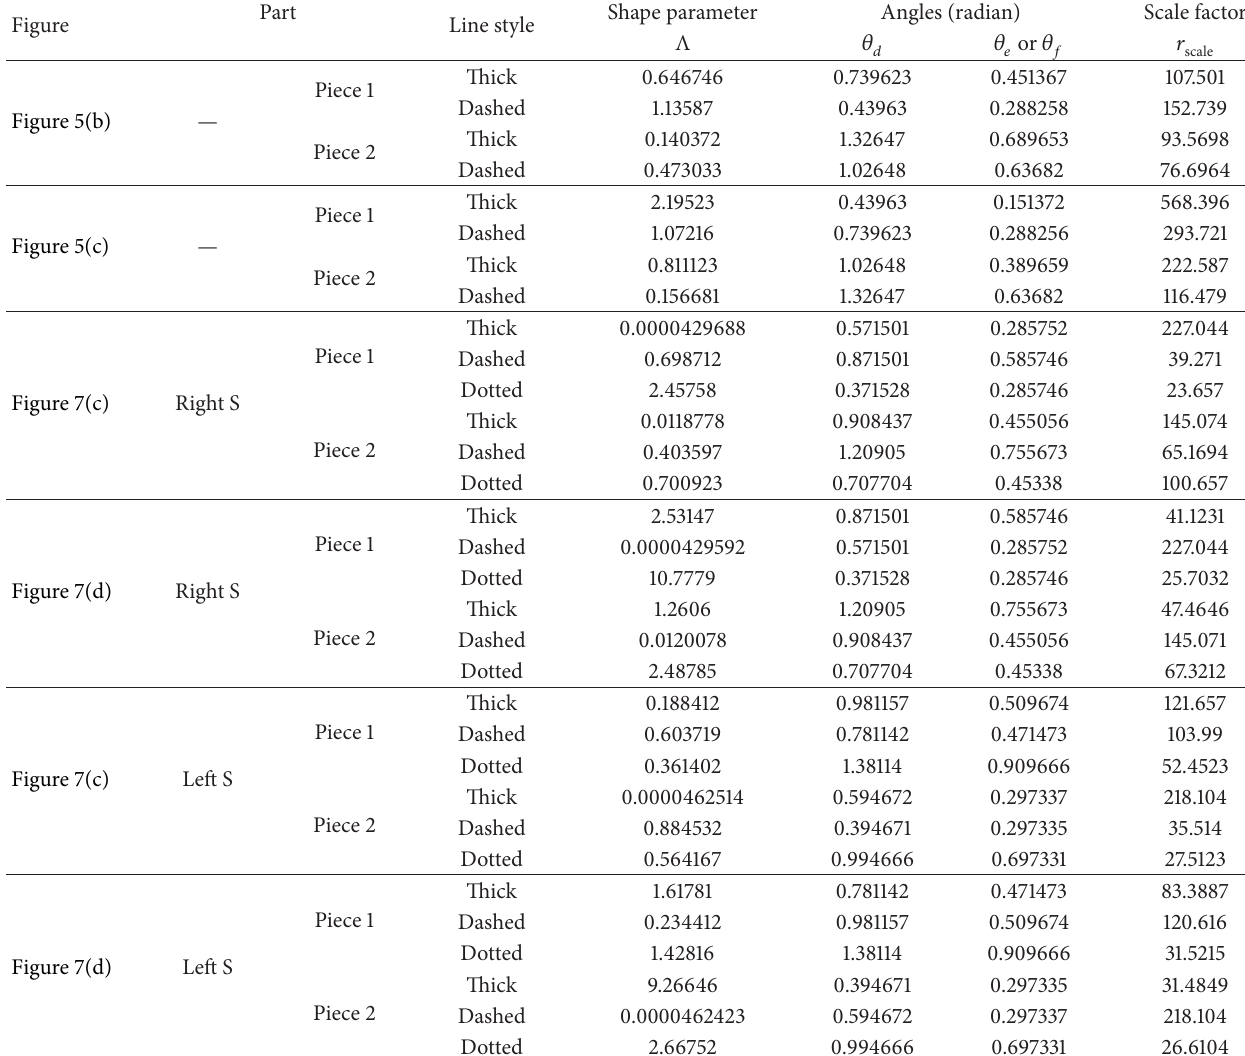
Table 3: The value of parameters obtained in LAC algorithm for S-shaped